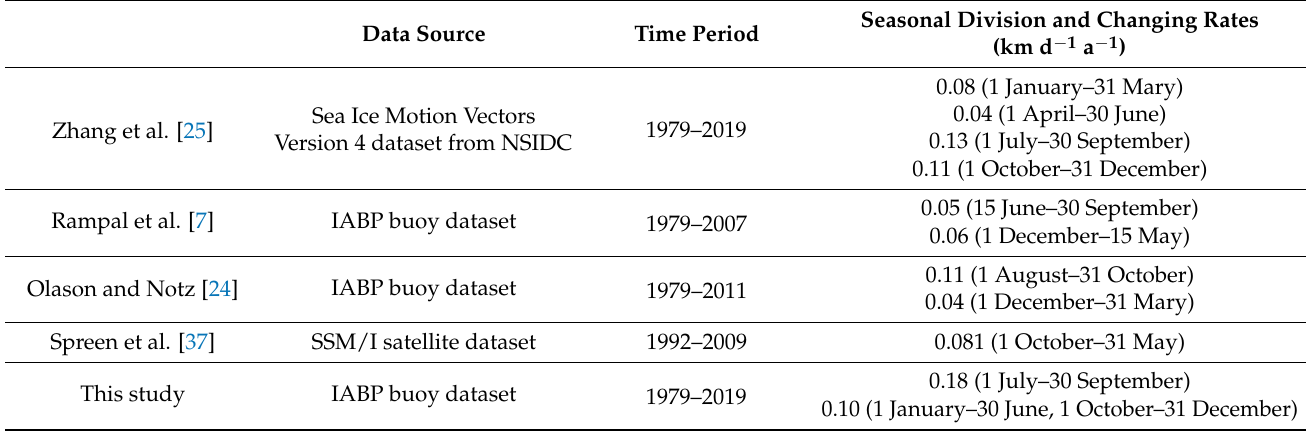
Table 1. Trends of sea ice drift speed in the Arctic Ocean obtained from this study and previous works.